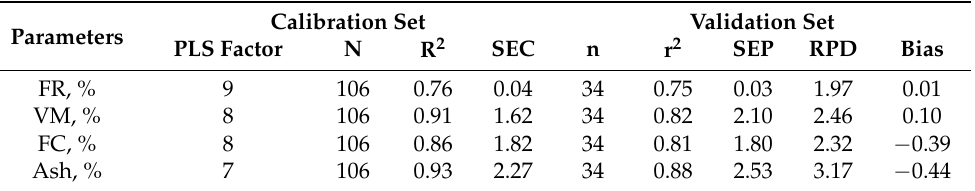
Table 4. The result of the best PLS regression model using iSPA wavelengths for the prediction of various biomass pellets in the calibration set and the validation set. Calibration Set Validation Parameters